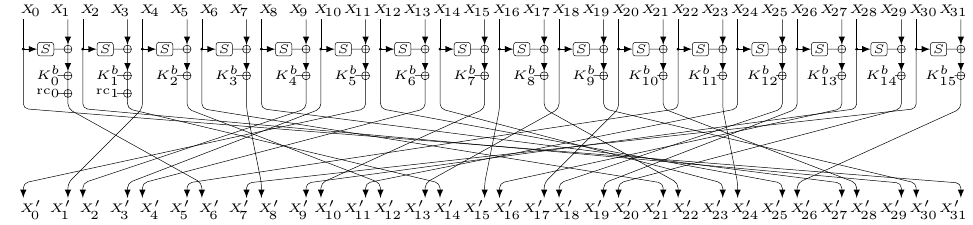
Figure 5: The round function of WARP